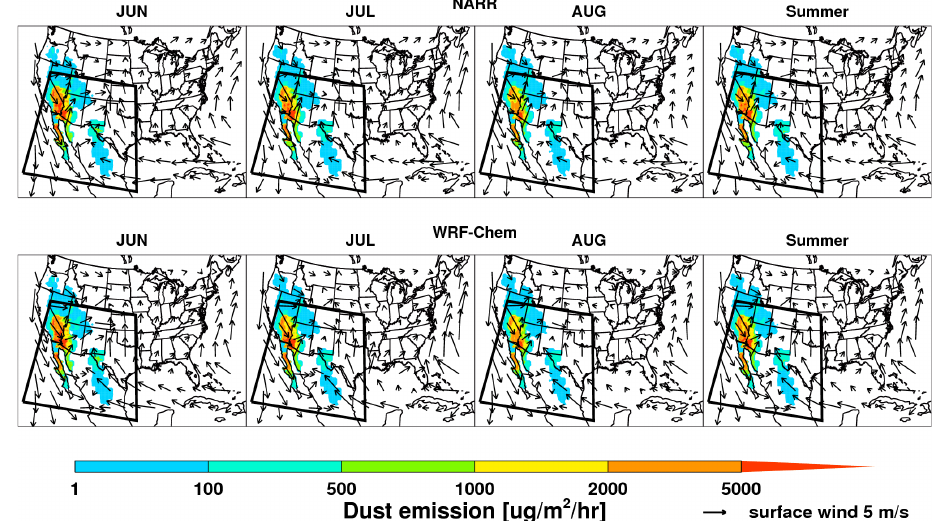
Fig. 1. Spatial distributions of 10-m wind from NARR reanalysis data and WRF-Chem simulations and dust emissions from WRF-Chem Figure 1 Spatial distributions of 10-m wind from NARR reanalysis data and WRF-Chem 5 simulations in June, July, August, and summer averaged for 1995–2009. The region in black box is defined as the North America Monsoon (NAM) region (20 ◦ N–40 ◦ N, 120 ◦ W–95 ◦ simulations and dust emissions from WRF-Chem simulations in June, July, August, and 6 summer averaged for 1995-2009. The region in black box is defined as the North 7